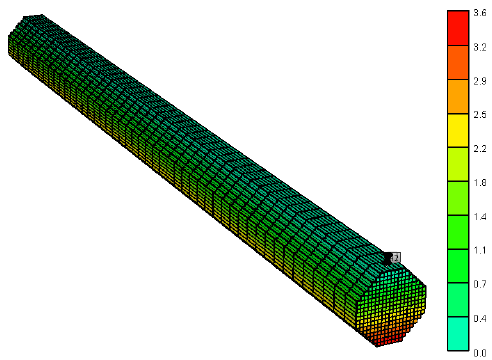
Figure 5. One-dimensional numerical simulation model.